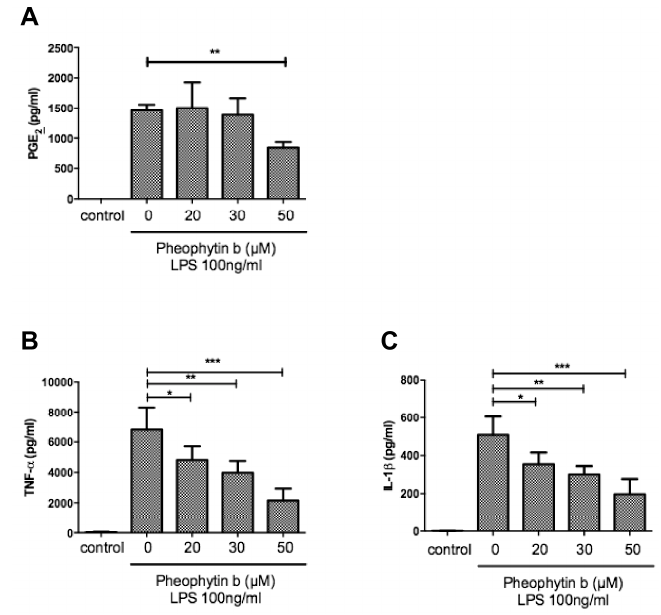
Figure 5. Pheophytin-b ameliorates cytokine expression induced by LPS in RAW 264.7 cells. RAW 264.7 cells were pre-treated with the indicated concentrations of pheophytin-b for 30 min followed by LPS (100 ng/mL) treatment for 24 h. TNF- α , IL-1 β , IL-6, and IL-10 concentrations were measured in the culture supernatants by ELISA. Results show the means ± SEM of three experiments. * p < 0.05 vs. cells treated with LPS alone (by Student’s t -test, n = 3).